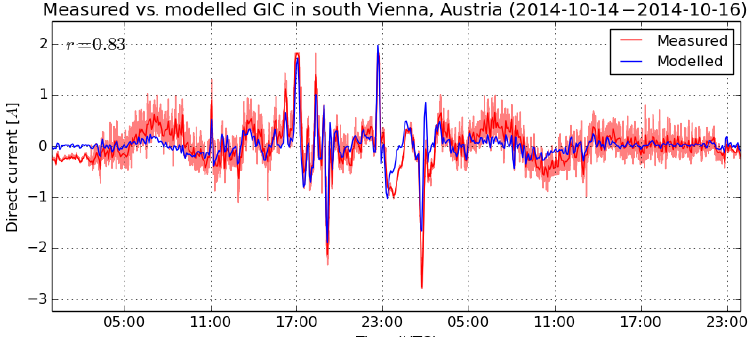
Figure 5. Modelled GICs (blue) in comparison to the measurements (red). The raw measurements are plotted in lighter red and the solid red line are the measurements that have been filtered to remove noise and reduce to the same sampling rate of 300s for comparison to the model. The value in the top left is the Pearson’s correlation coefficient r between the model and filtered